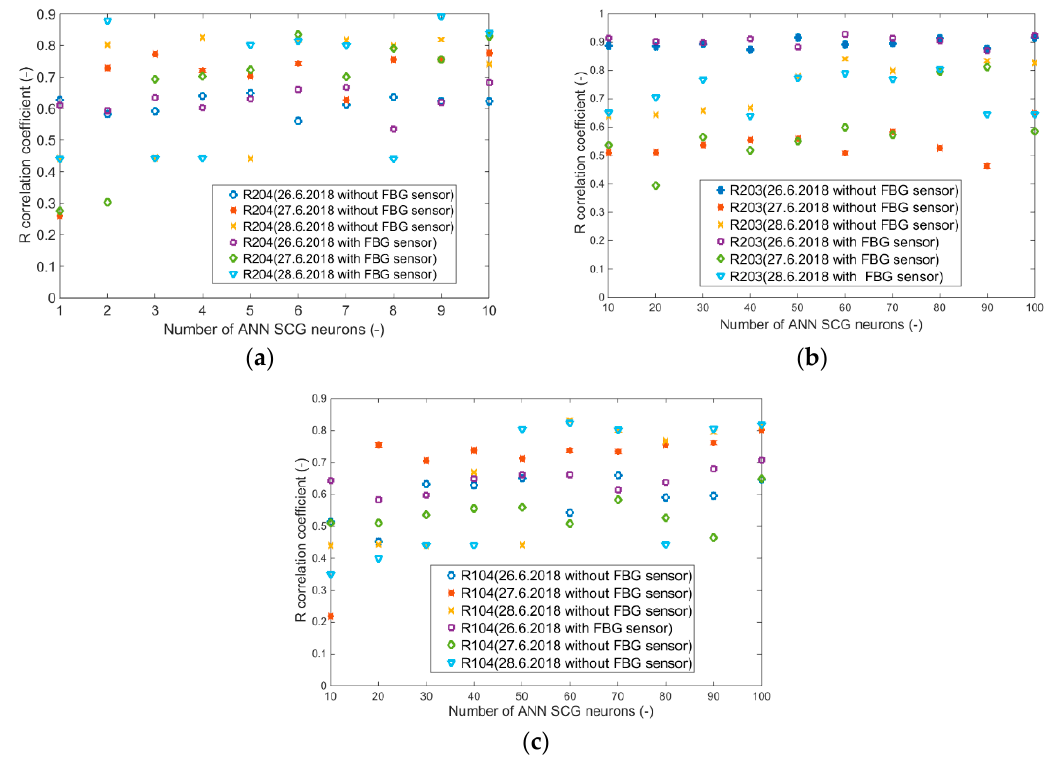
Figure 32. R-correlation coefficients for ( a ) room R203 with and without FBG, ( b ) room R204 with and without FBG, ( c ) room R104 with and without FBG.